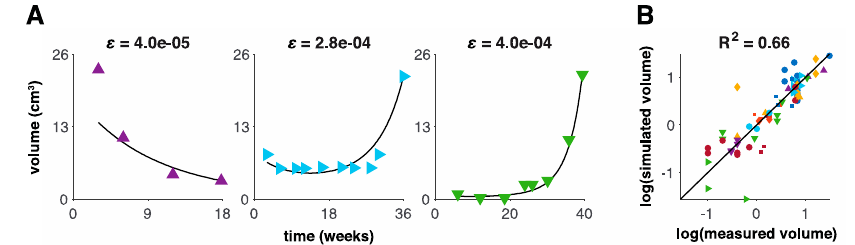
Figure 4. Model validation. ( A ) Fits of three representative patients (low, medium, and high ε ). ( B ) Model fits to the patient dataset with R 2 = 0.66 for one particular leave-one-out cross-validation (LOOCV) replicate. Each point represents a single MRI scan, and each symbol represents a single patient. The calculation of the coefficient of determination (R 2 ) was based on absolute tumor volumes without logarithmic transformation.